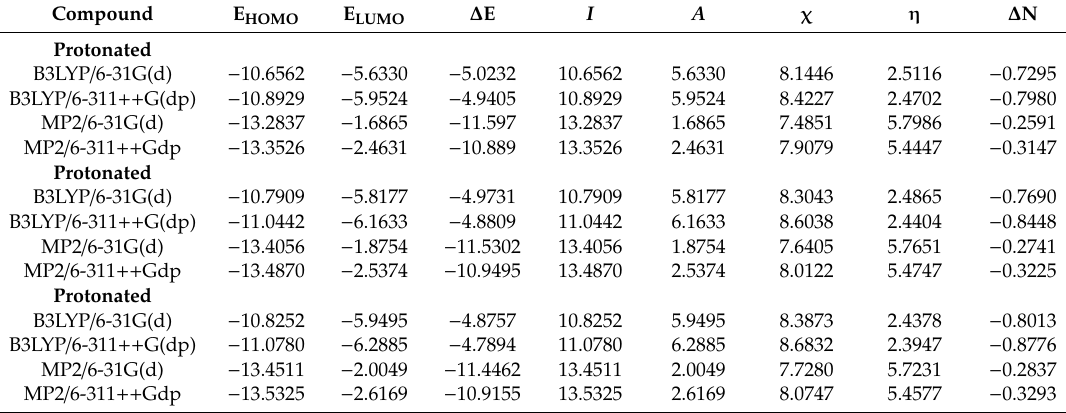
Table 3. The calculated quantum chemical parameters of protonated ca ff eine, theobromine, and theophylline in the gas phase at di ff erent levels of theory. (All values are in eV). Compound E